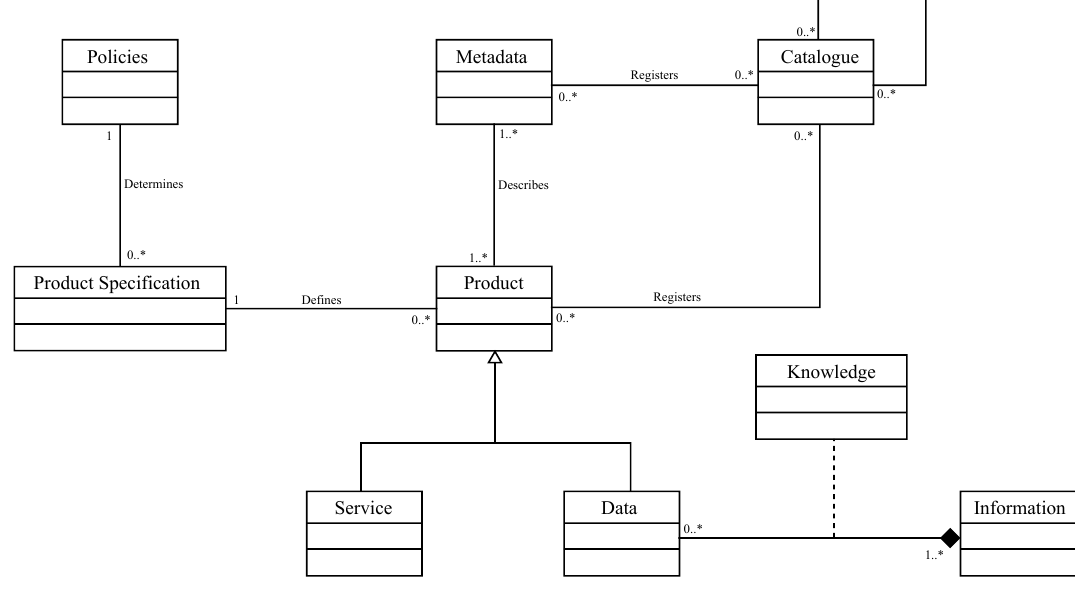
Figure 4. Class diagram for the Information viewpoint. Source: